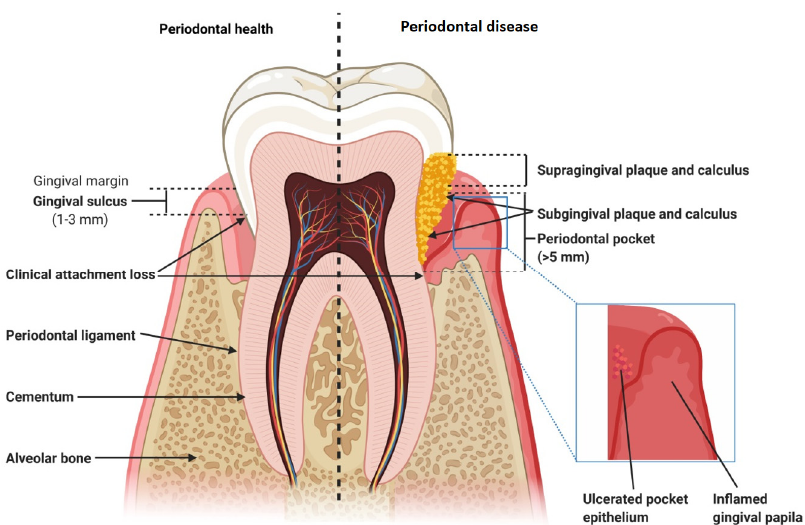
Figure 2. The progression from periodontal health to periodontitis disease. The alveolar bone and connective tissue are covered by the oral epithelium in periodontal health, and the gingival sulcus is 1–3 mm. However, periodontitis is developed when the periodontal pockets are <5 mm deep, and gingival inflammation in sites with apical migration of the epithelial attachment onto the root surfaces is associated with loss of connective tissue and alveolar bone